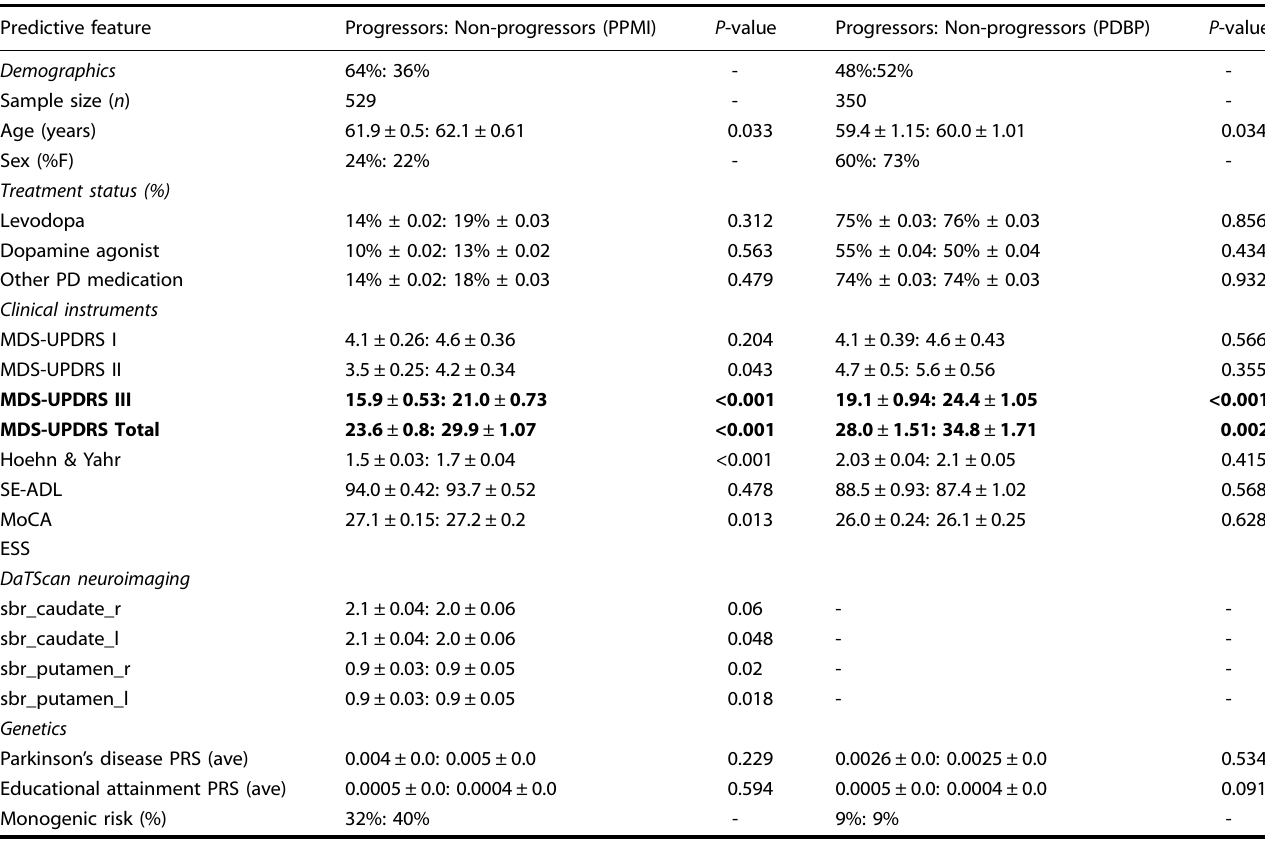
Table 1. Baseline characteristics of 12-month MDS-UPDRS total progressors vs non-progressors. Predictive